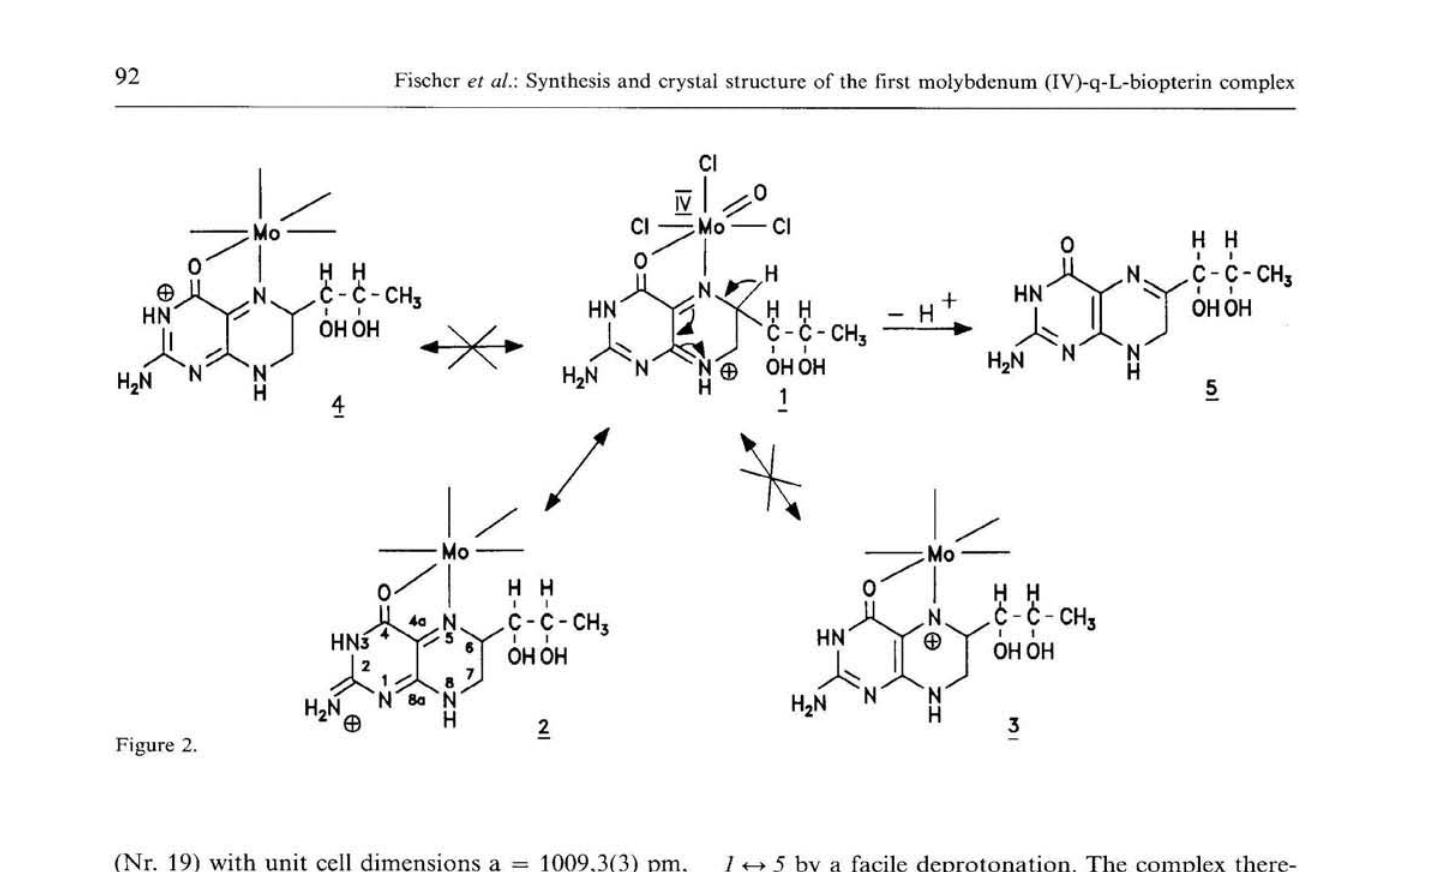
(Nr. 19) with unit cell dimensions a = 1009,3(3) pm, b = 1104,7(3) pm, c = 1484,5(4) pm and Ζ = 4. The molybdenum atom has a distorted octahedral geom- etry. It is coordinated by N(5) and 0(4) of the pterin ligand. The distance of the Mo-N(5) bond (202 pm) is unusually short compared to similar complexes. 0(4) is located trans to a terminal oxo ligand. The octahedral coordination is completed by three chlor- ine atoms in a meridional